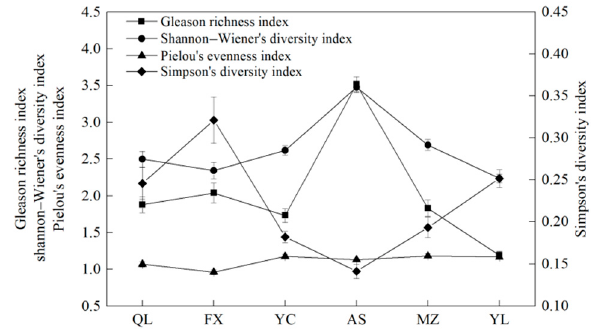
Figure 4. Variations of vegetation characteristics at different sites along the climatic gradient.